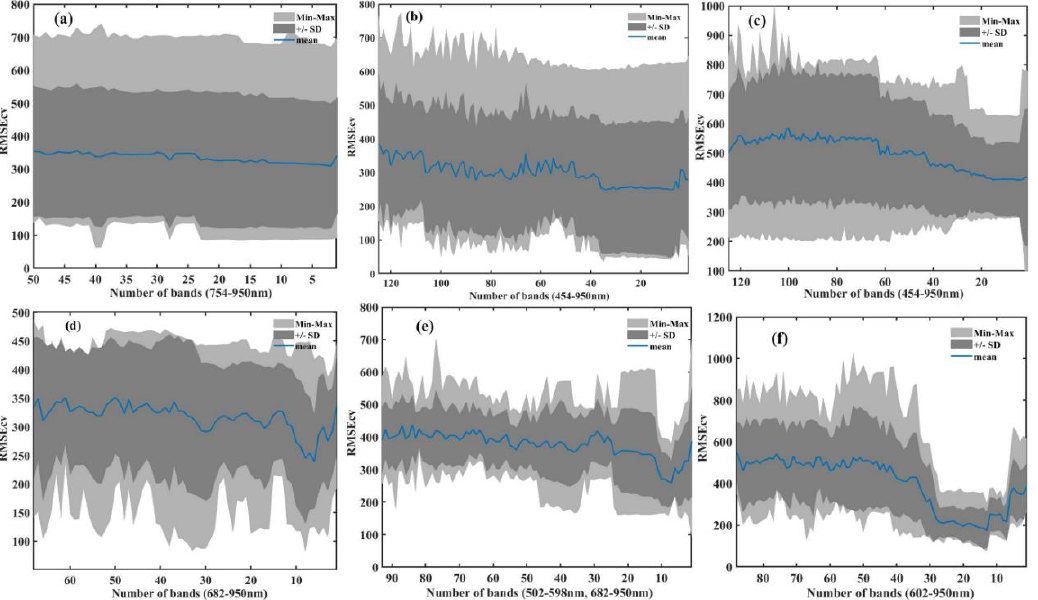
Figure 4. Determination of COS and FDS spectral features for use in estimating potato AGB. Panels ( a ) and ( d ) show the cross-validation RMSEcv statistics (mean, standard deviation, and min–max ranges) obtained by applying the GPR-BAT to the COS and FDS, respectively, for the tuber-formation stage. Panels ( b , e ) show the same for the tuber-growth stage, and panels ( c , f ) show the same for the starch-storage stage. Table 3. COS and FDS features selected by GPR-BAT for the tuber-formation, tuber-growth, and starch-storage periods.